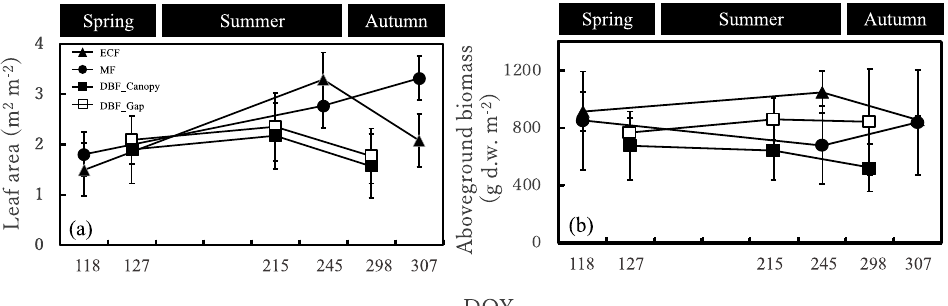
Figure 4. ( a ) Leaf area and ( b ) aboveground biomass of the Sasa community in the four sites. DOY, day of year. ECF, MF, DBF_Canopy and DBF_Gap in the graph indicate evergreen coniferous forest, mixed forest, and canopy area in the broadleaved deciduous forest and gap area in the deciduous broadleaved forest, respectively.